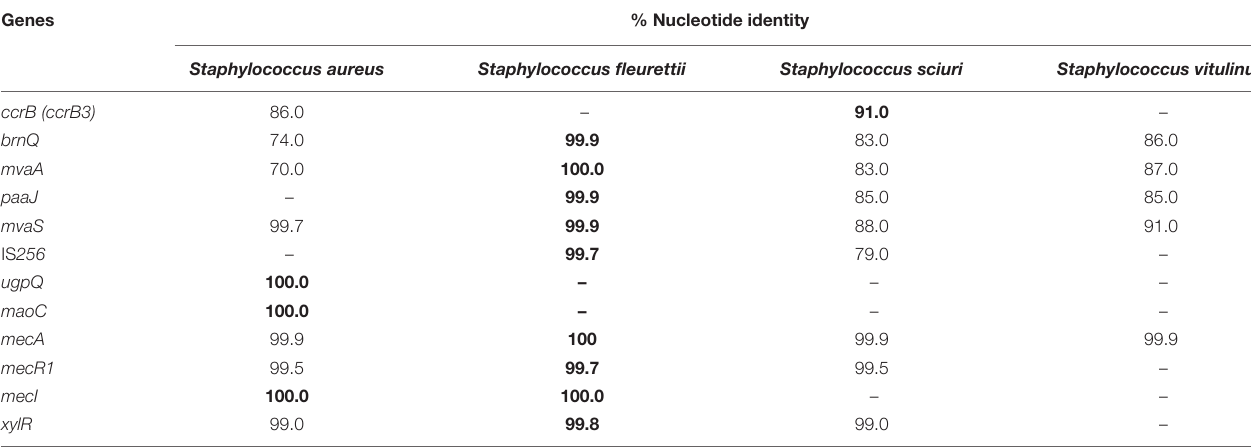
TABLE 2 | SCC mec -associated genes carried by a Staphylococcus saprophyticus strain (KS295) in lineage S and their homology with those found in other staphylococcal species. Genes % Nucleotide